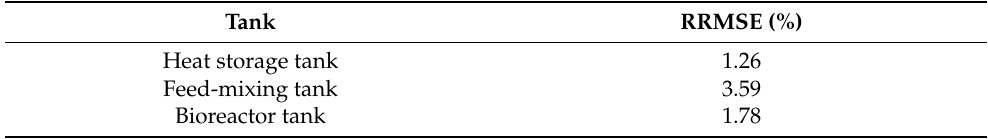
Table 8. RRMSE for the heat storage, feed-mixing, and bioreactor